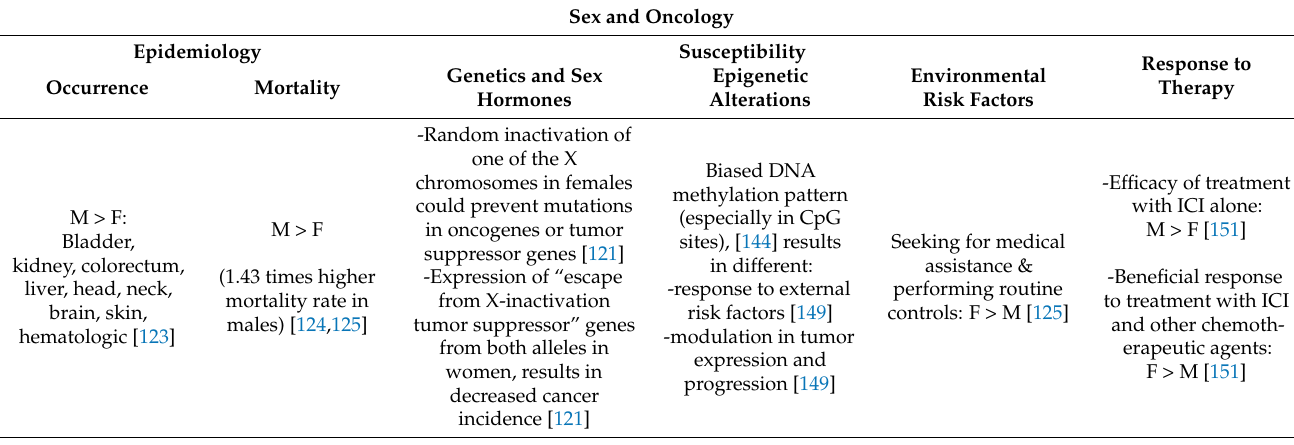
Table 4. Sex differences in oncology. Some sex differences in terms of occurrence, mortality and response to therapy are reported. The mechanisms involved in this disparity seem to involve environmental risk factors, sex hormones, genetics and epigenetic